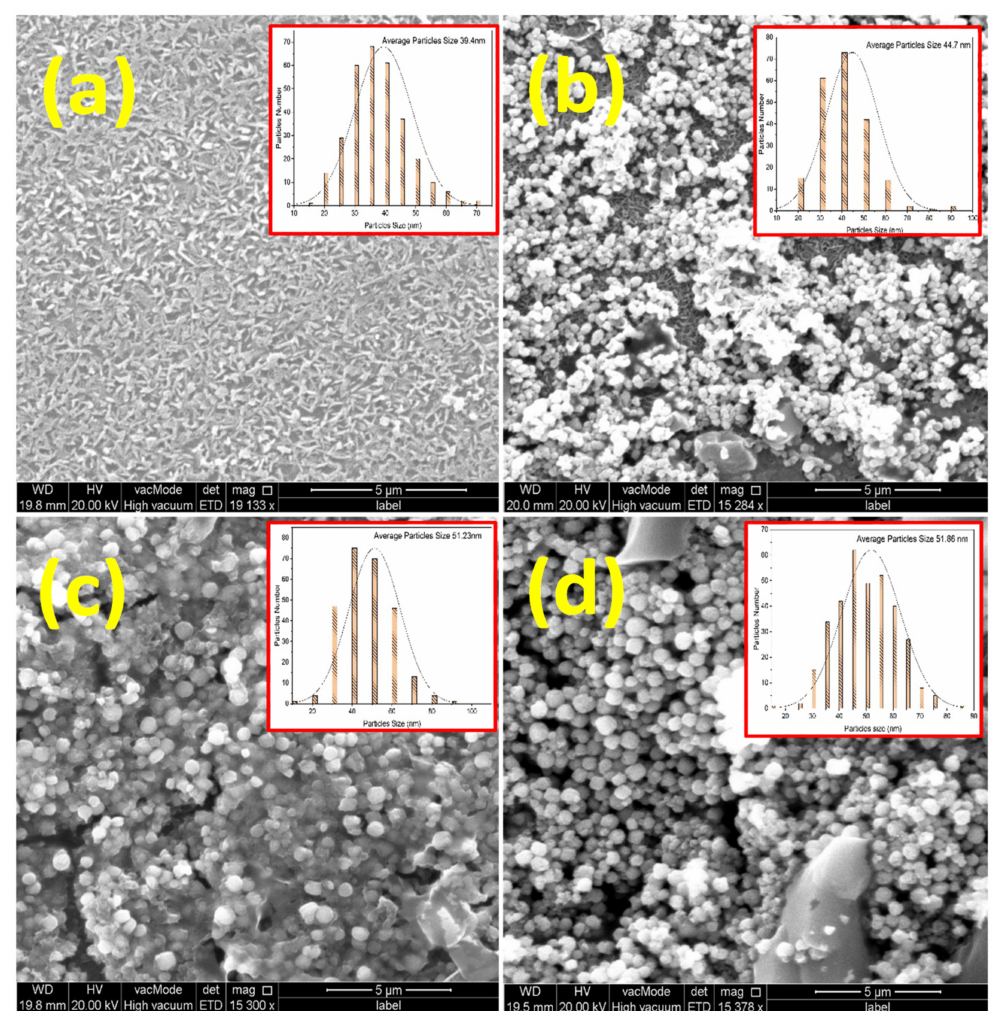
Figure 5. The FESEM top-view images of ZnO nanoparticles synthesized by using a green method and the leaf extract of the thyme plant at different calcination temperatures: ( a ) 150 ◦ C, ( b ) 250 ◦ C, ( c ) 350 ◦ C, and ( d ) 450 ◦